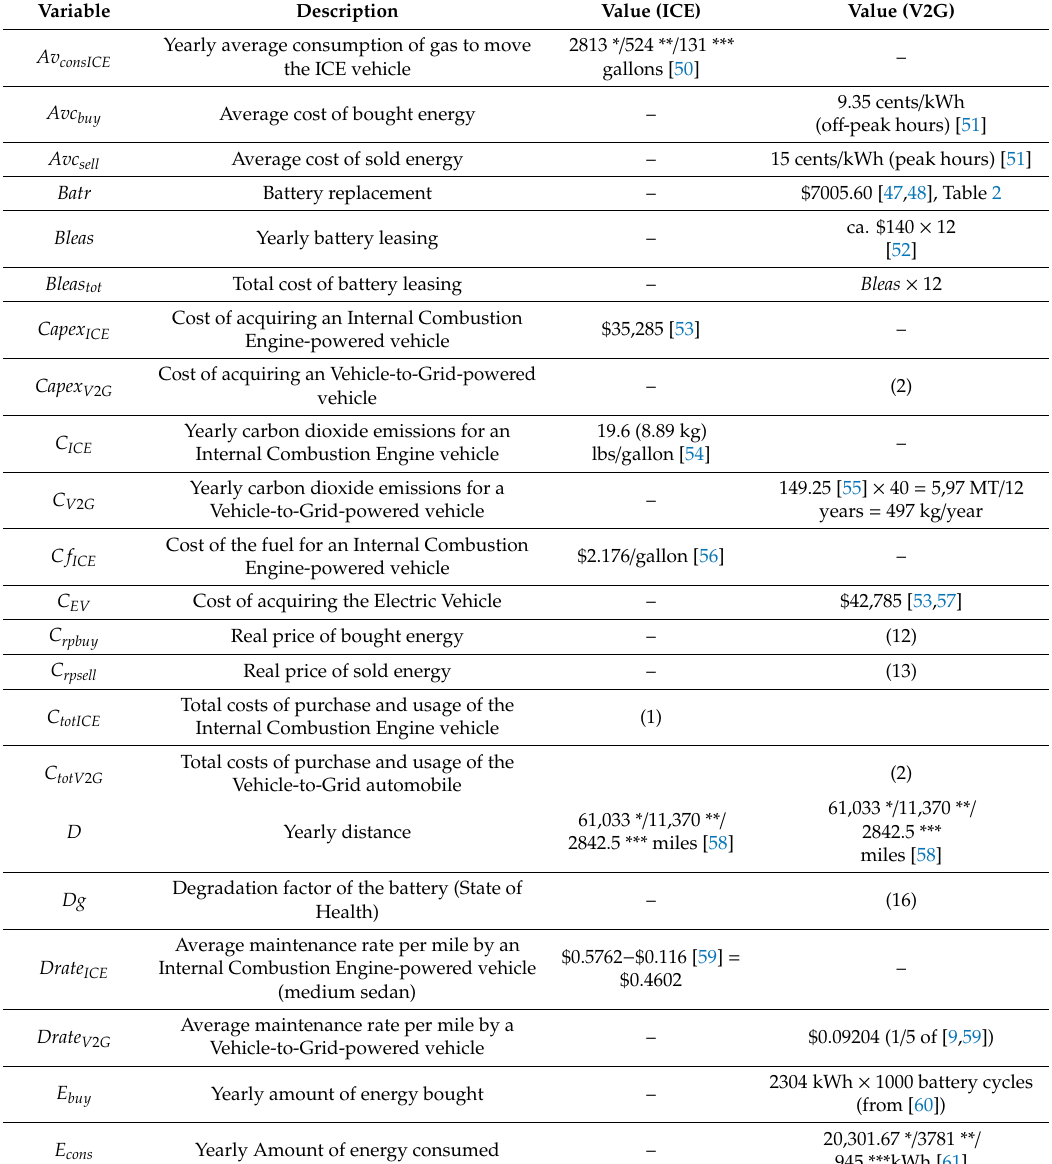
Table 3. Variables included in the mathematical